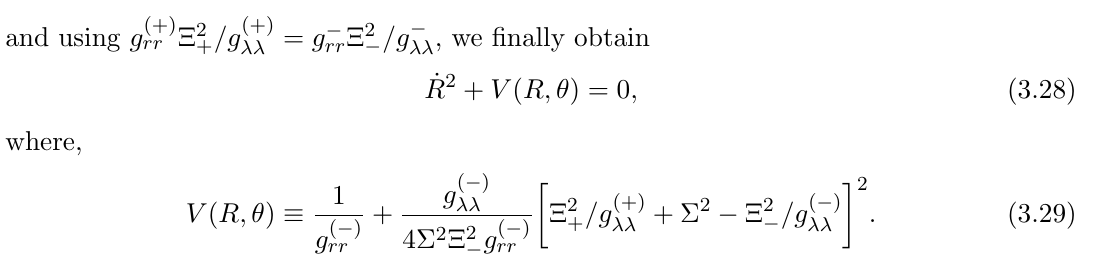
Figure 5 . The e(cid:11)ective potential governing the position of the wall with a= ( GM ) = 0, 0 : 6, and 0 : 99. The blue and green points in (a) show R = R min and R = R max , respectively. In the Euclidean oscillation phase ( R min (cid:20) R (cid:20) R max ), there is less dependence on (cid:18) . Here we take r s = 10 3 ‘ Pl , H = 1 (cid:2) 10 (cid:0) 4 M Pl , (a) (cid:6) =M Pl = 2 (cid:2) 10 (cid:0) 5 , (b)3 (cid:2) 10 (cid:0) 5 , and (c) 6 (cid:2) 10 (cid:0) 5